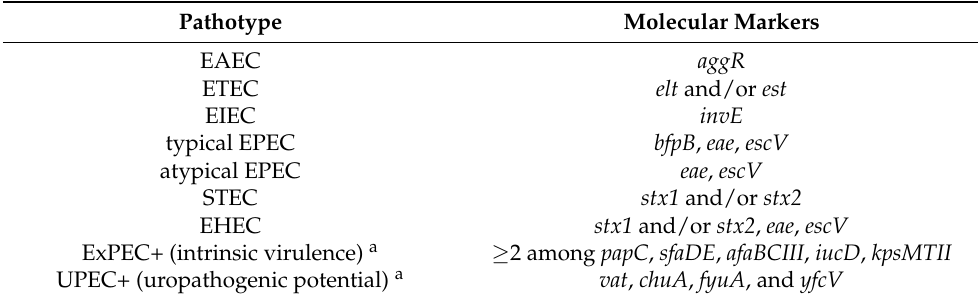
Table 1. Molecular markers used to identify the Escherichia coli pathotypes. Pathotype Molecular Markers EAEC aggR ETEC elt and/or